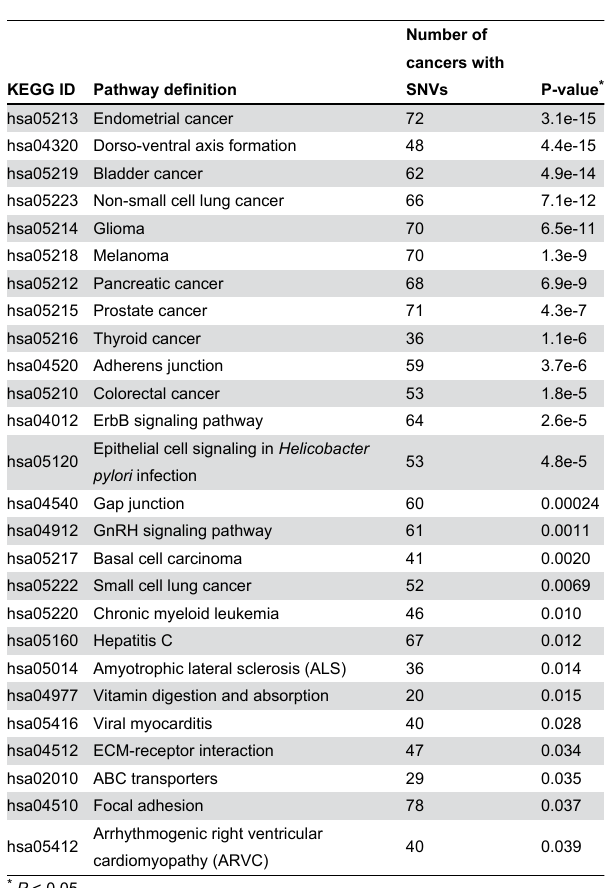
Table 2. List of the identified possible cancer-related pathways.